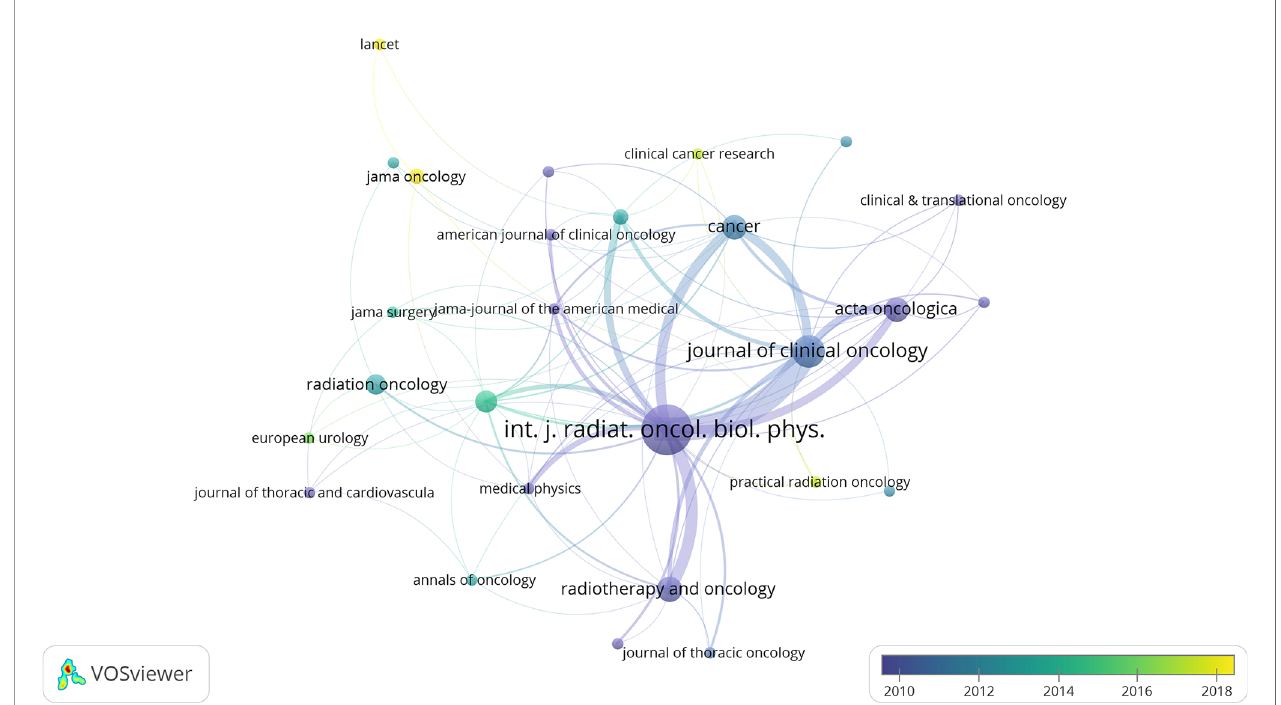
FIGURE 2 | The network visualization of journals from the 100 most cited articles according to the average published year. The circle size represents the number of articles in the 100 most cited articles. The width of the curved line represents the link strength. The distance between 2 journals approximately indicates the relatedness of the